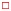
Brain deformation during hydrocephalus development.Brain deformation of hydrocephalic rats (□) were characterized from day three by a significantly (a) higher ventricle system cross-sectional area and (b) whole brain cross-sectional area, (c) a smaller caudate-putamen cross-sectional area at day three and day seven and also (d) a thinner cortical gray matter from day seven than control rats (□). P values for significance of the interaction between groups in the RM two-way ANOVA tests and significant Sidak’s comparisons are reported for each graph.